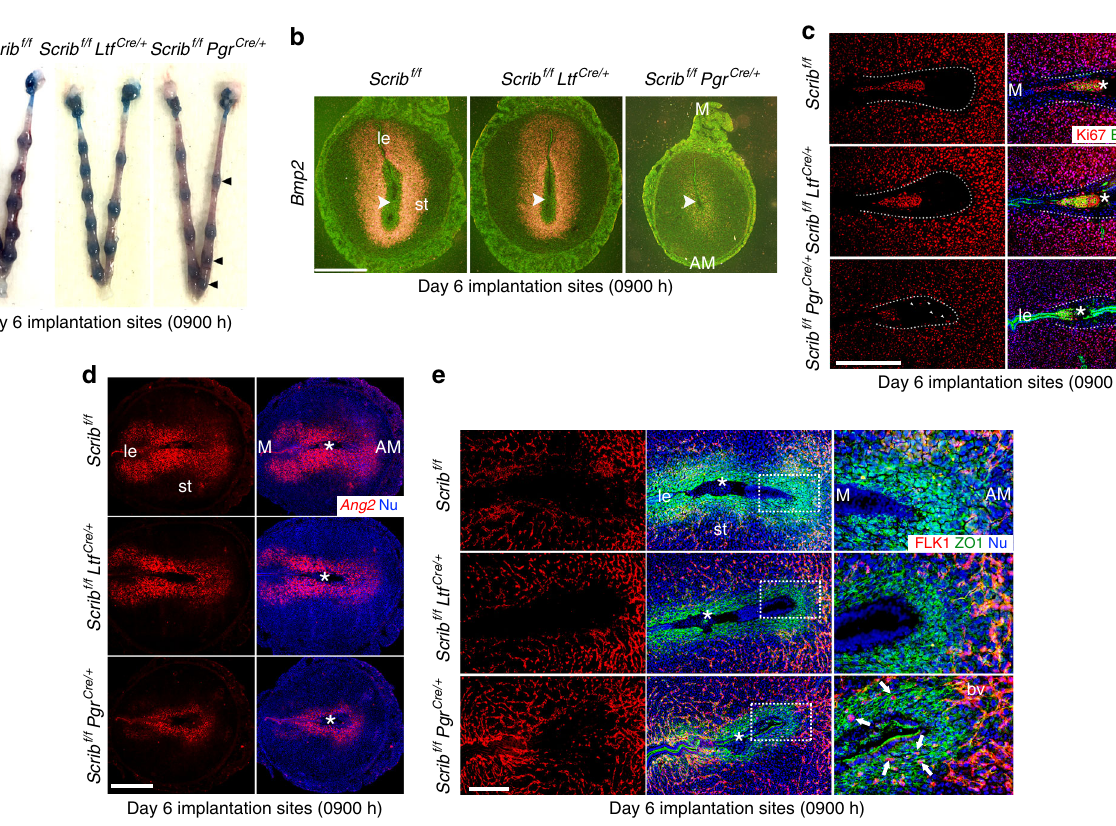
Fig. 6 Scrib deletion in stroma impedes formation of avascular PDZ. a Representative images of implantation sites in Scrib f/f , Scrib f/f Ltf cre/ + , and Scrib f/ f Pgr cre/ + mice on day 6. Arrowheads indicate weak implantation sites. b In situ hybridization of Bmp2 in Scrib f/f , Scrib f/f Ltf cre/ + , and Scrib f/f Pgr cre/ + mice implantation sites on day 6. Arrowheads indicate the location of blastocysts. Scale bar: 200 μ m. c IF of Ki67 and E-cad in Scrib f/f , Scrib f/f Ltf cre/ + , and Scrib f/ f Pgr cre/ + mice on day 6 implantation sites. Insides of dotted lines indicate PDZ, arrowheads indicate Ki67 positive stromal cells in PDZ area. Scale bar: 400 μ m. d In situ hybridization of Ang-2 in Scrib f/f , Scrib f/f Ltf cre/ + , and Scrib f/f Pgr cre/ + mice implantation sites on day 6. Scale bar: 500 μ m. e IF of ZO-1 and FLK-1 in day 6 implantation sites of Scrib f/f , Scrib f/f Ltf cre/ + , and Scrib f/f Pgr cre/ + mice show blood vessels invaded the PDZ in Scrib f/f Pgr cre/ + mice as indicated by arrows. Scale bar: 200 μ m. Asterisks indicate the location of embryos. Each image is a representative of at least three independent experiments. M mesometrial pole, AM antimesometrial pole, le luminal epithelium, st stroma, bv blood